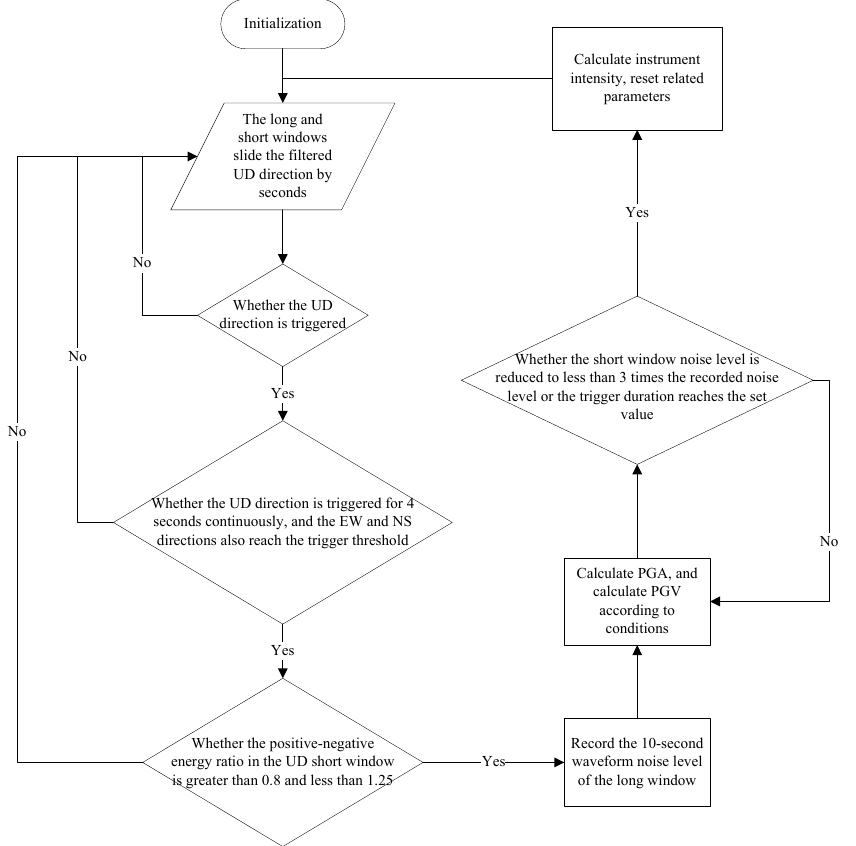
Figure 5. Decision tree representing the seismic event discrimination and calculations needed to determine the ground motion parameters.